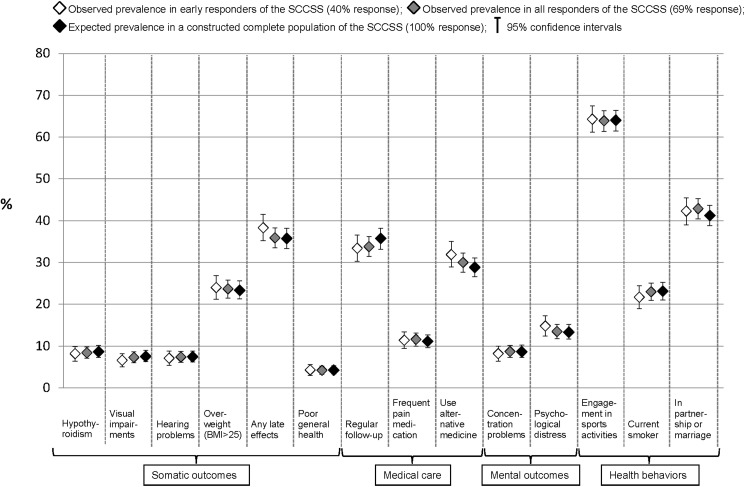
Comparison of self-reported outcomes between early responders, late responders, and a constructed complete population of the Swiss Childhood Cancer Survivor Study.Proportions and 95% confidence intervals for typical self-reported outcomes for somatic health, medical care, mental health, and health behaviors, comparing the observed prevalence from early responders (designated with a white diamond) and all responders (designated with a grey diamond) of the SCCSS with the expected prevalence in the representative complete population (designated with a black diamond). We constructed the complete population with inverse probability of participation weights (S1 File) (22). S1 Table describes how each of the outcomes compared was assessed and classified. Abbreviations: BMI, Body Mass Index; SCCSS, Swiss Childhood Cancer Survivor Study.